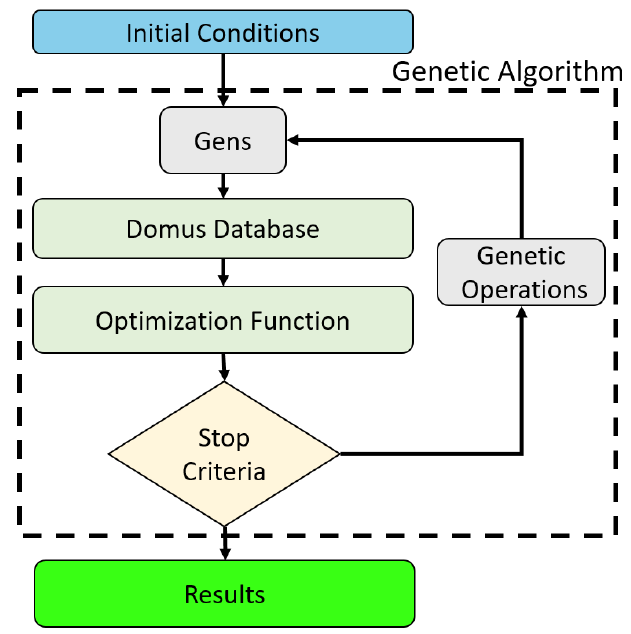
Figure 2. Flowchart applied in optimization by genetic algorithm (GA).